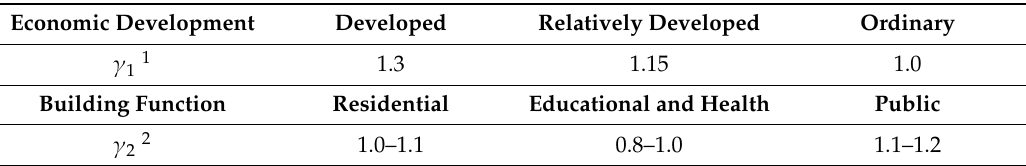
Table 8. Value ranges for correction coe ffi cients for di ff erences in economic development levels ( γ 1 ) and building functions (unit: